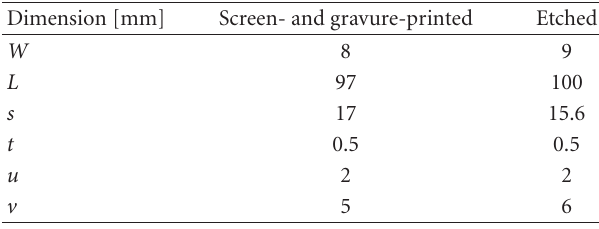
Table 2: Characteristics of screen printable ink.